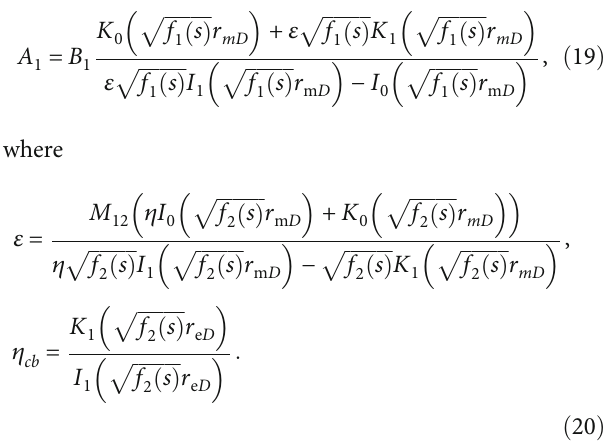
ffiffiffiffiffiffiffiffiffiffi